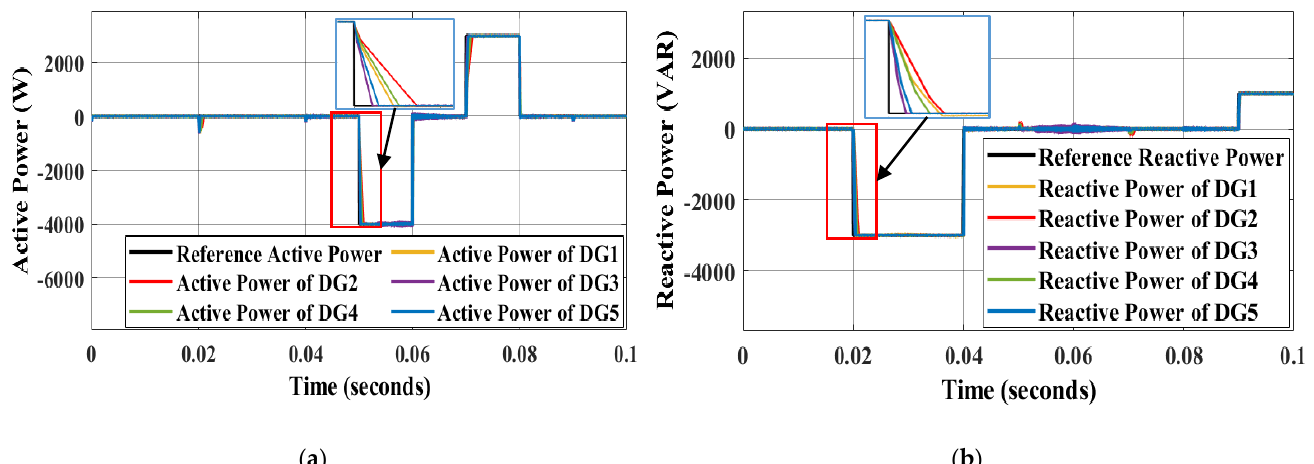
Figure 19. Individual DG power flow control under the second case study without an outage DG: